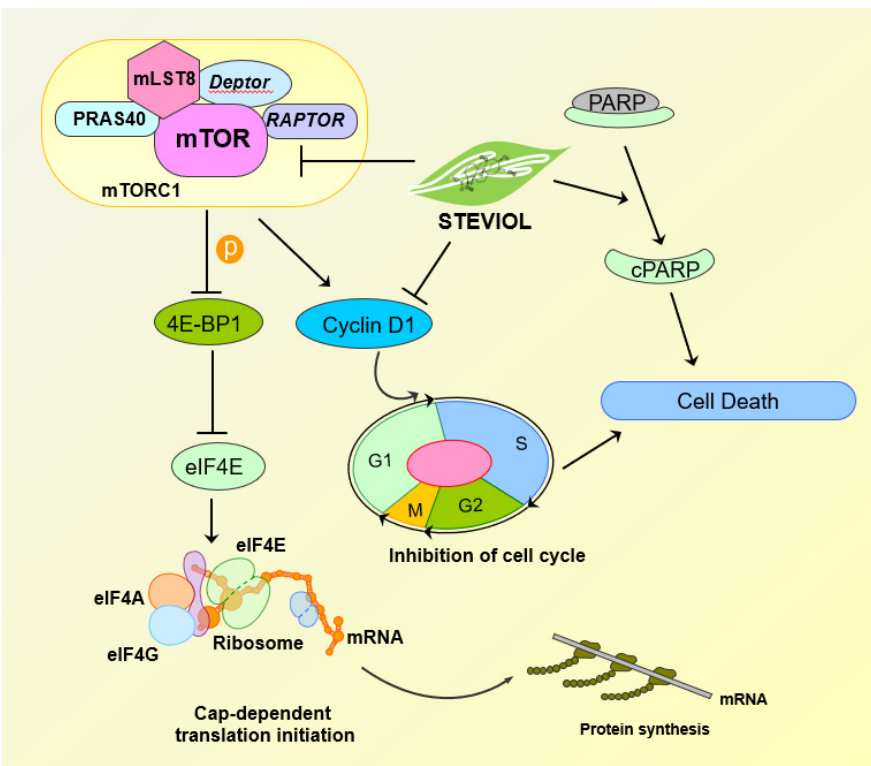
Figure 7. Schematic representation depicting mechanism of action of steviol in pancreatic cancer. The lines represent direct or indirect activation (arrow head) and inactivation (blunt end) by various signaling molecules.